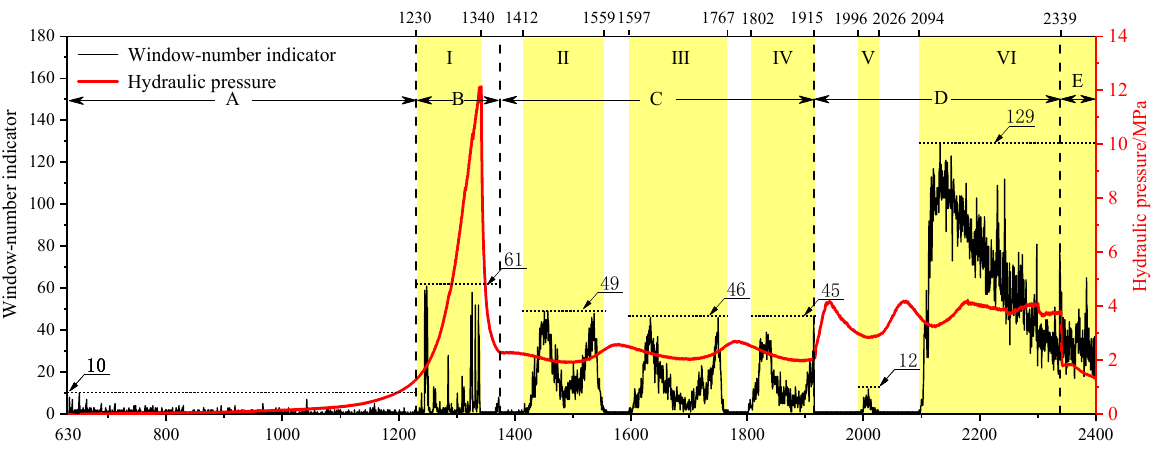
Figure 11. Hydraulic pressure and window-number indictor curve in HF. Table 5. Window-number indicators in six regions (regions I~VI) during